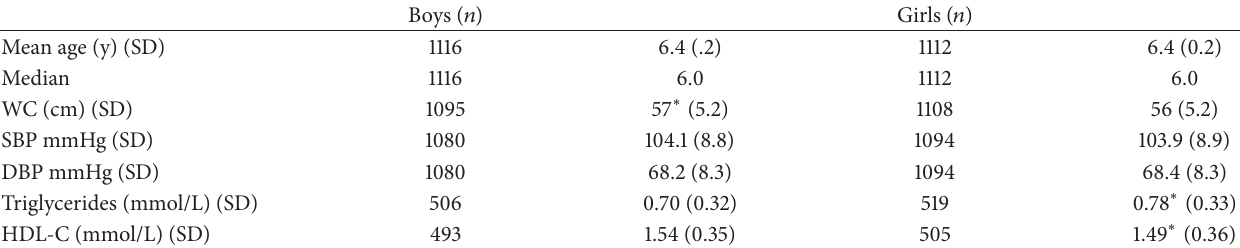
Table 1: Components of the metabolic syndrome in 2228 first graders; mean (SD).